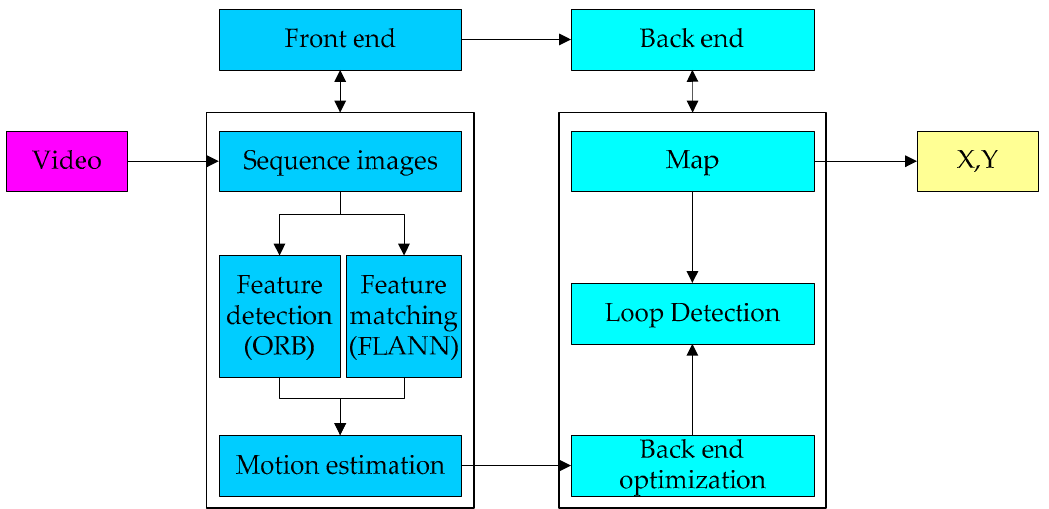
Figure 3. A rough flowchart of oriented fast and rotated brief ‐ simultaneous localization and mapping (ORB ‐ SLAM).